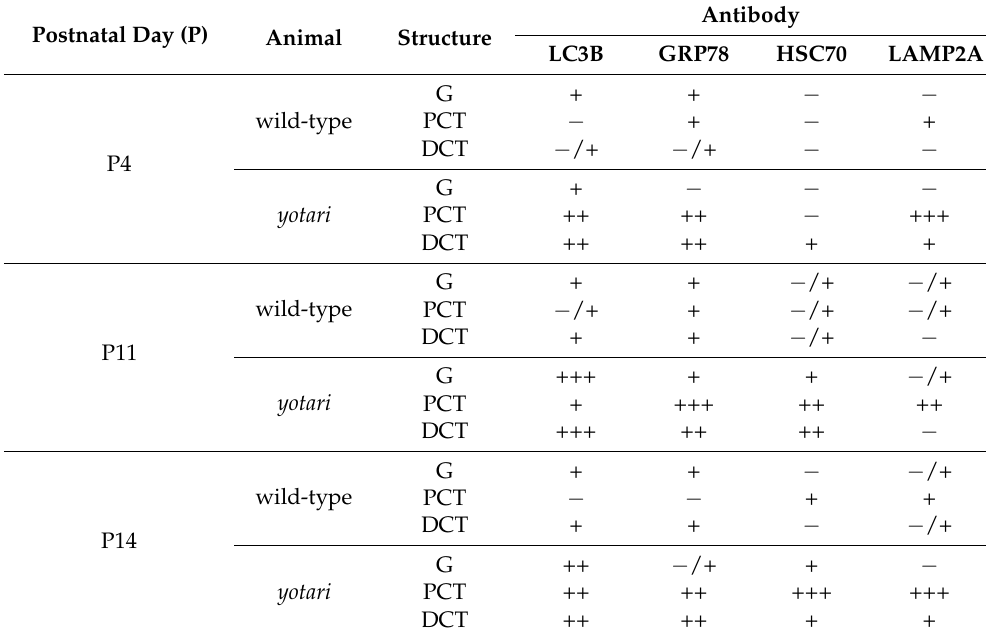
Table 3. Staining intensity of specific antibodies in the kidneys of yotari and wild-type mice at postnatal days P4, P11, and P14. Postnatal Day (P) Animal Structure